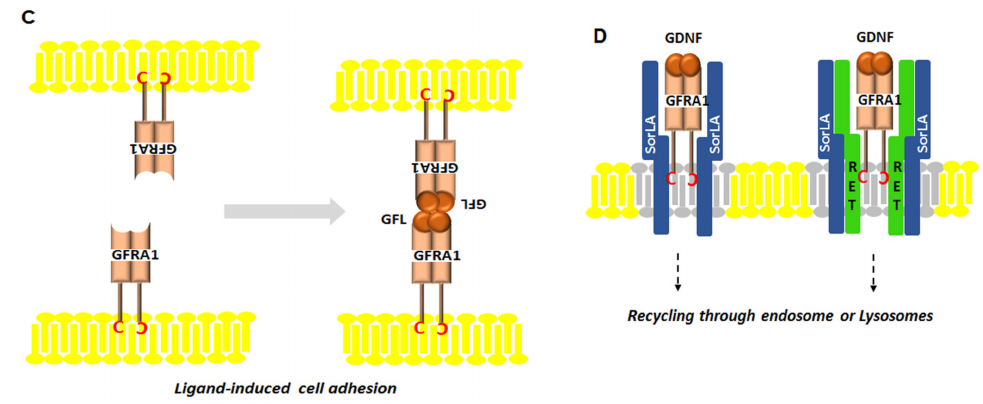
Figure 3. Schematic presentation of regulatory mechanisms of GFL-GFRA1 signaling. ( A ) RET is recruited to the lipid microdomain (or lipid rafts) by GPI-anchored GFRA1 (left side, cis-signaling) and by soluble GFRA1 (right side, sGFRA1, trans-signaling) released from plasma membrane. During cis-signaling, GFRA1 is anchored to lipid rafts by GPI, allowing GFLs to bind to GFRA1 to transduce their signals to co-receptor RET which can then activate downstream targets like Src kinase, PLC γ , or PI3K/AKT. Trans-signaling occurs when the GDNF/sGFRA1 complex binds to RET on another peripheral neuron which does not express GFRA1. GDNF/sGFRA1/RET can then transduce their signal to downstream targets such as PI3K/AKT and PLC γ /Cdk5, resulting in neuronal survival and neurite outgrowth; ( B ) In the absence of GFLs, short-range signaling by homophilic interactions between p140 NCAM can be disrupted by the presence of GFRA, resulting in the inhibition of cell adhesion, or extracellular signaling crosstalk (left side). In the presence GFLs, the association of membrane-bound GFRA with p140 NCAM results in the activation of the Fyn-FAK-MAPK signaling pathway (right side); ( C ) Ligand-induced cell adhesion; ( D ) Recycling of GDNF/GFRA1/RET complex by SorLA. SorLA/GFRA1-mediated GDNF uptake occurs by RET-independent endocytosis. SorLA/GFRA1 complex directs GDNF to lysosome. SorLA/GFRA1-mediated RET endocytosis is independent of